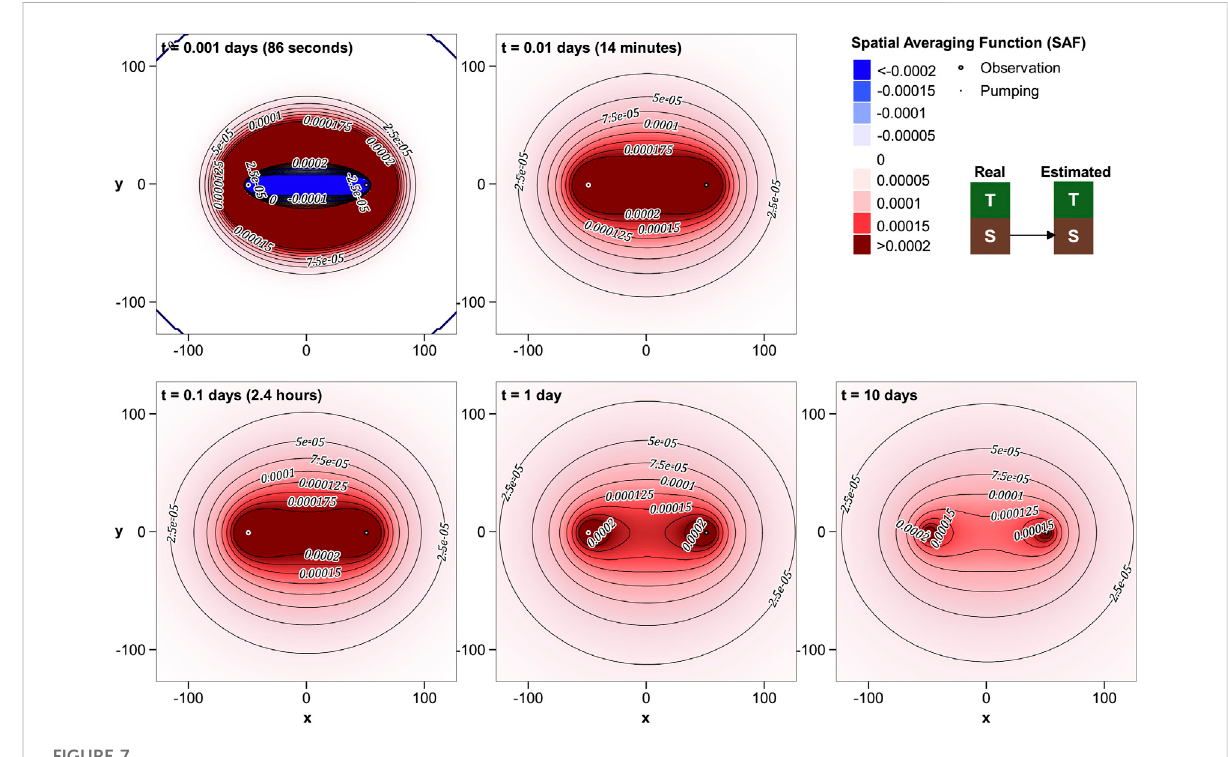
FIGURE 7 R ′ S − S for separated wells at fi ve different